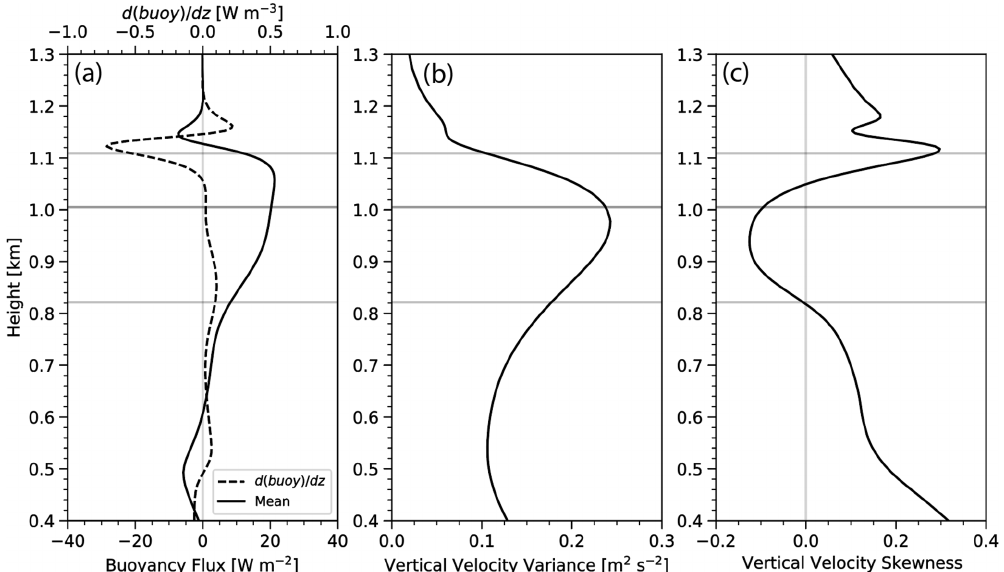
Figure 5. Vertical profiles of the horizontally averaged (a) buoyancy flux, (b) vertical velocity variance, and (c) vertical velocity skewness. The dashed line in panel (a) represents the first derivative of the buoyancy flux. The gray lines are as in Fig.